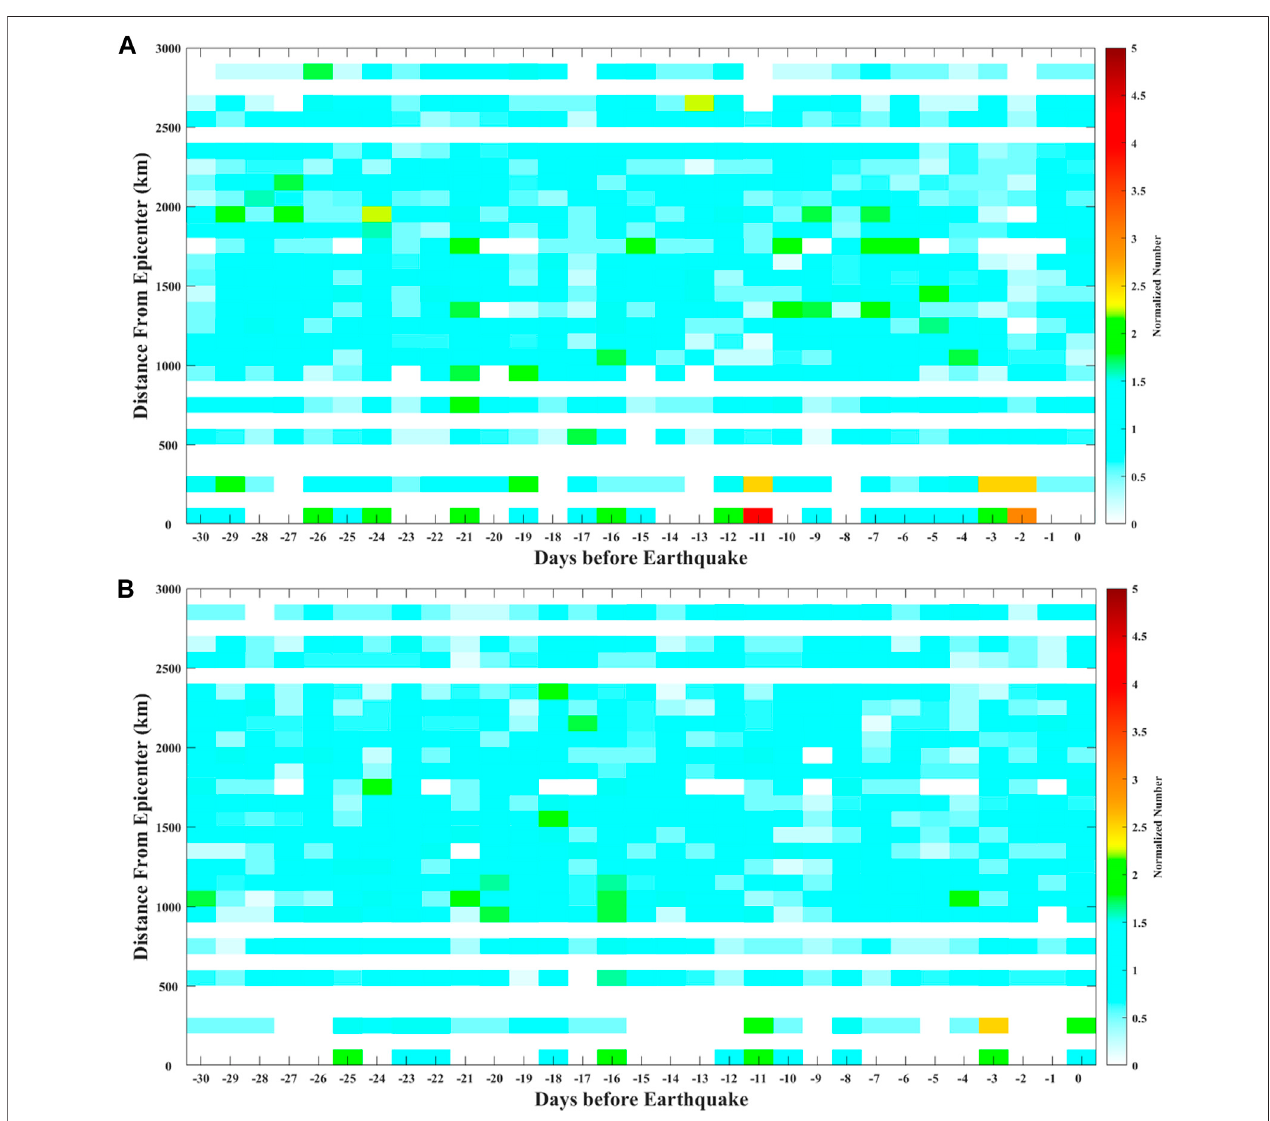
FIGURE 9 | Statistical result of seismo-ionospheric disturbances with the days before earthquake ( X axis) and distance from the epicenter ( Y -axis) by SESA. (A,B) Statisticalresultsofrealandrandomearthquakes,respectively.ThecolorrepresentsthenormalizednumberbySESA,whichisillustratedinthetext.Thehorizontalwhite band of the picture means there is no data in this